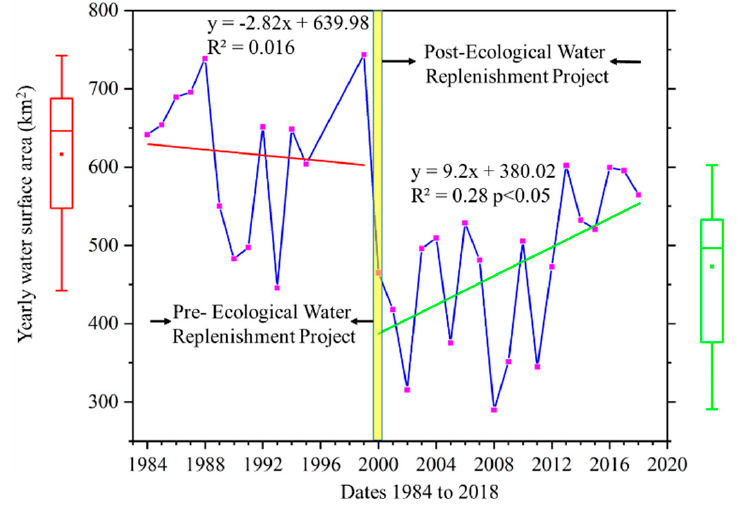
Figure 2. Time series (1984 – 2018) of annual water surface area. The red and green boxplots illustrate the median and inter-quartile range and the whiskers indicate minimum and maximum values.